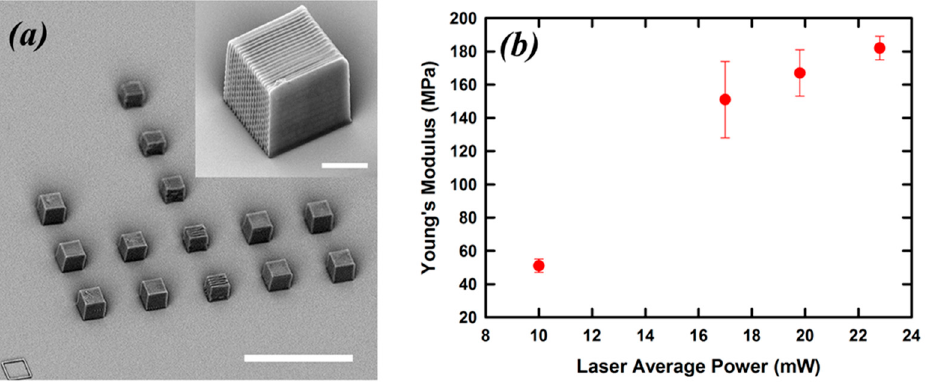
Figure 7. SEM of the TPP microstructures used in the mechanical testing ( a ); scale bare is 40 µm. A close-up image of one of the tested cubes ( b ); scale bar is 5 µm. Dependence of microstructures’ Young’s modulus on laser average power used to make them ( b ). Reproduced from [29].